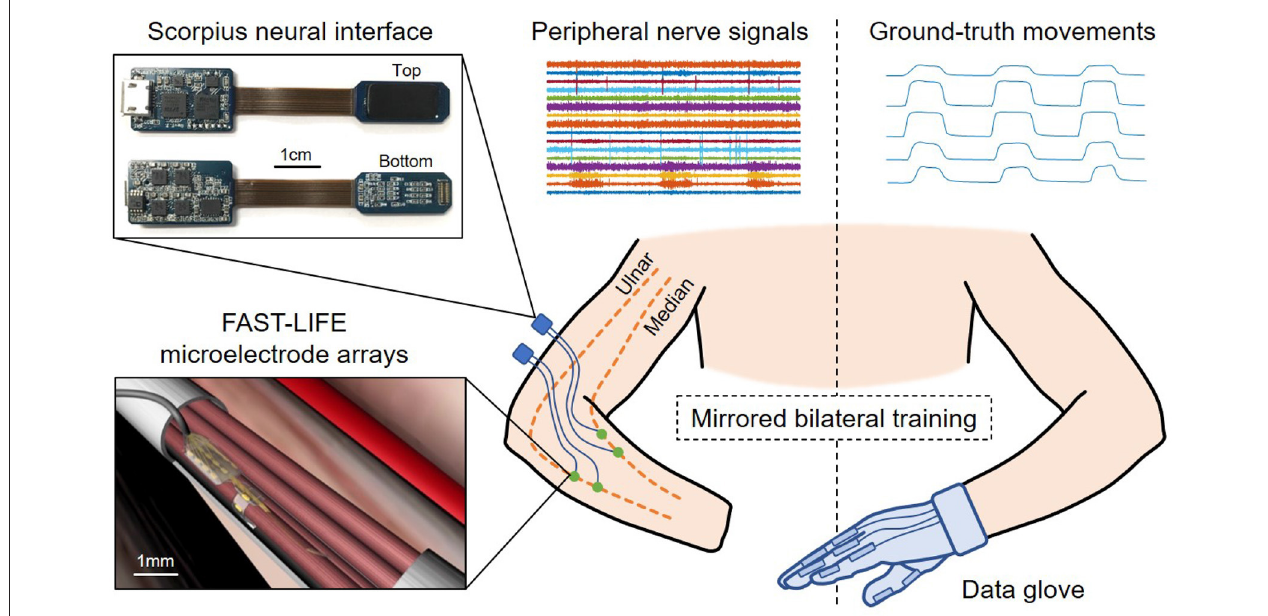
FIGURE 2 | Overview of the human experiment setup and data acquisition using the mirrored bilateral training. The patient has four FAST-LIFE microelectrode arrays implanted in the residual ulnar and median nerve (Overstreet, 2019). Peripheral nerve signals are acquired by two Scorpius neural interface devices (Nguyen and Xu, 2020 ). The ground-truth movements are obtained with a data